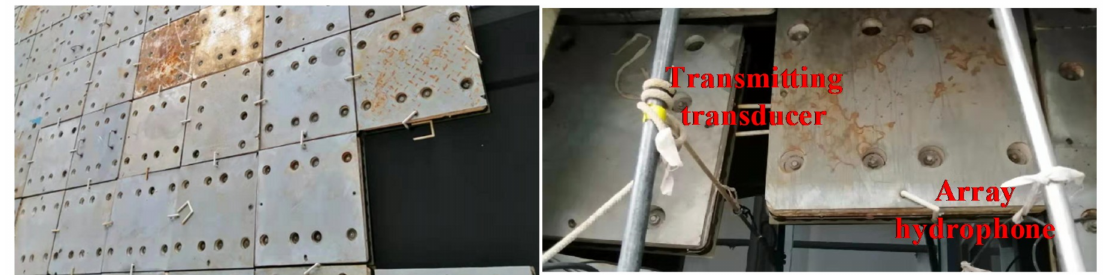
Figure 14. Positioning test of array MEMS hydrophone in the anechoic tank.